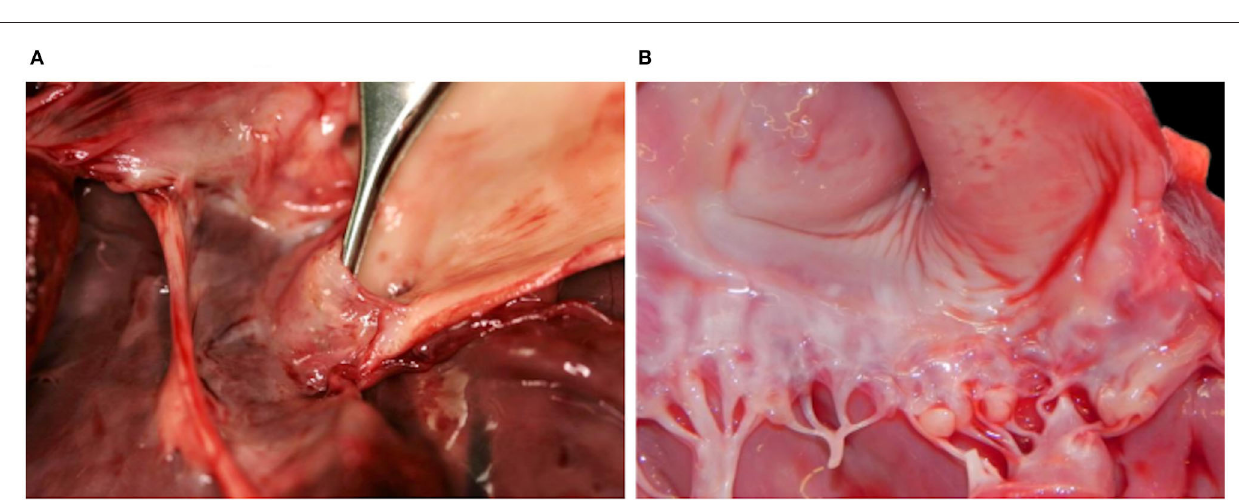
FIGURE 3 | Hearts with valvular changes, Eurasian Lynx ( Lynx lynx carpathicus ); (A) case 3, aortic valve: stenotic fibrotic ridge expanding from, and forming a recess at the base of, the epicardium, multifocally thickened in the area comprised between the ridge and the semilunar valve (subaortic stenosis); (B) case 4, mitral valve: multifocal thickening and partial retraction of valvular leaflets with mild to moderate nodular thickenings of the free margins (endocardiosis).